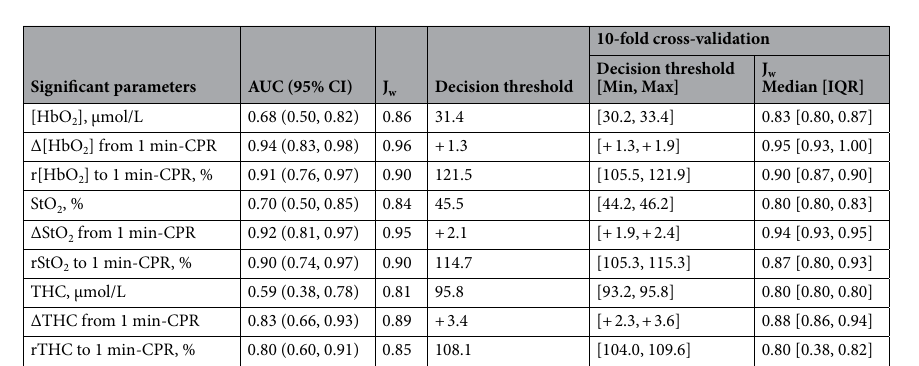
Table 3. Predictive performance and optimal decision threshold for significant cerebral hemodynamic parameters. AUC = area under curve of receiver-operating-characteristic; J w = maximum weighted